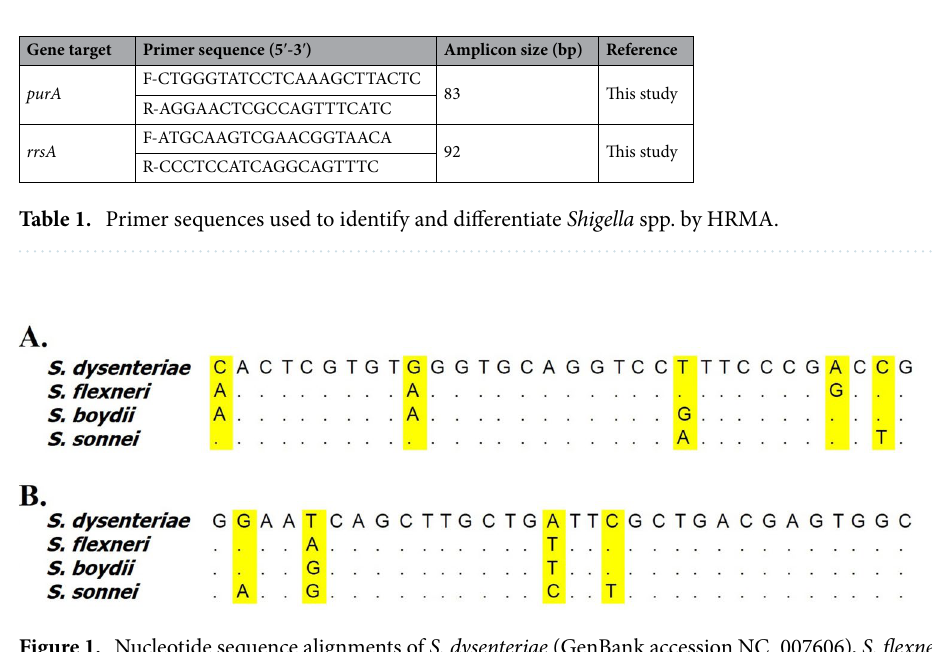
Figure 1. Nucleotide sequence alignments of S. dysenteriae (GenBank accession NC_007606), S. flexneri (NC_004741), S. boydii (NC_010658) and S. sonnei (NC_007384). ( A ) Primer pair purA-F-A and ( B ) primer pair